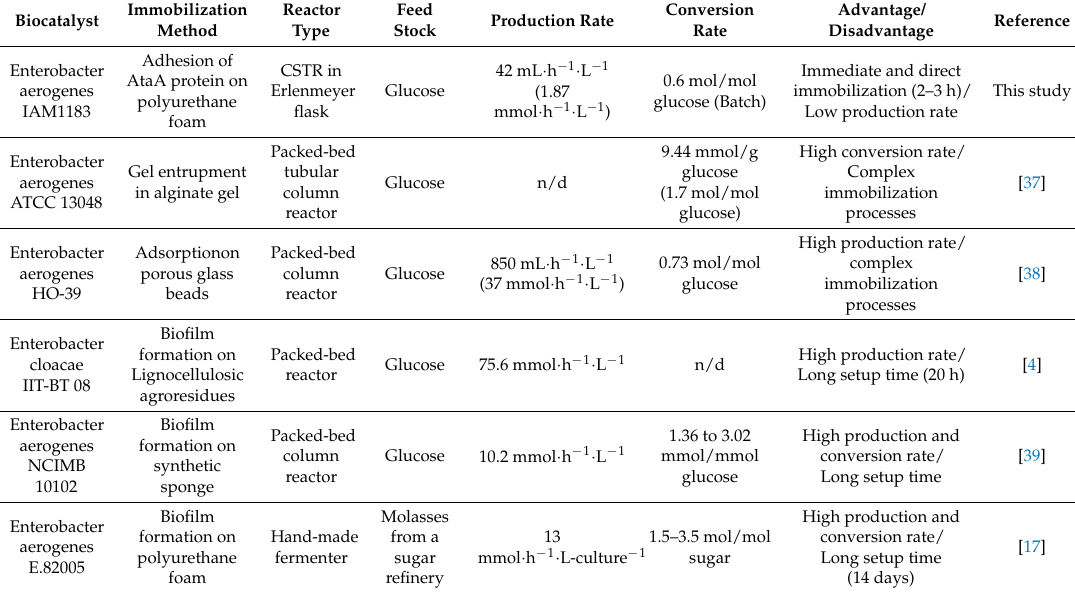
Table 1. Comparison of hydrogen production with immobilized Enterobacter